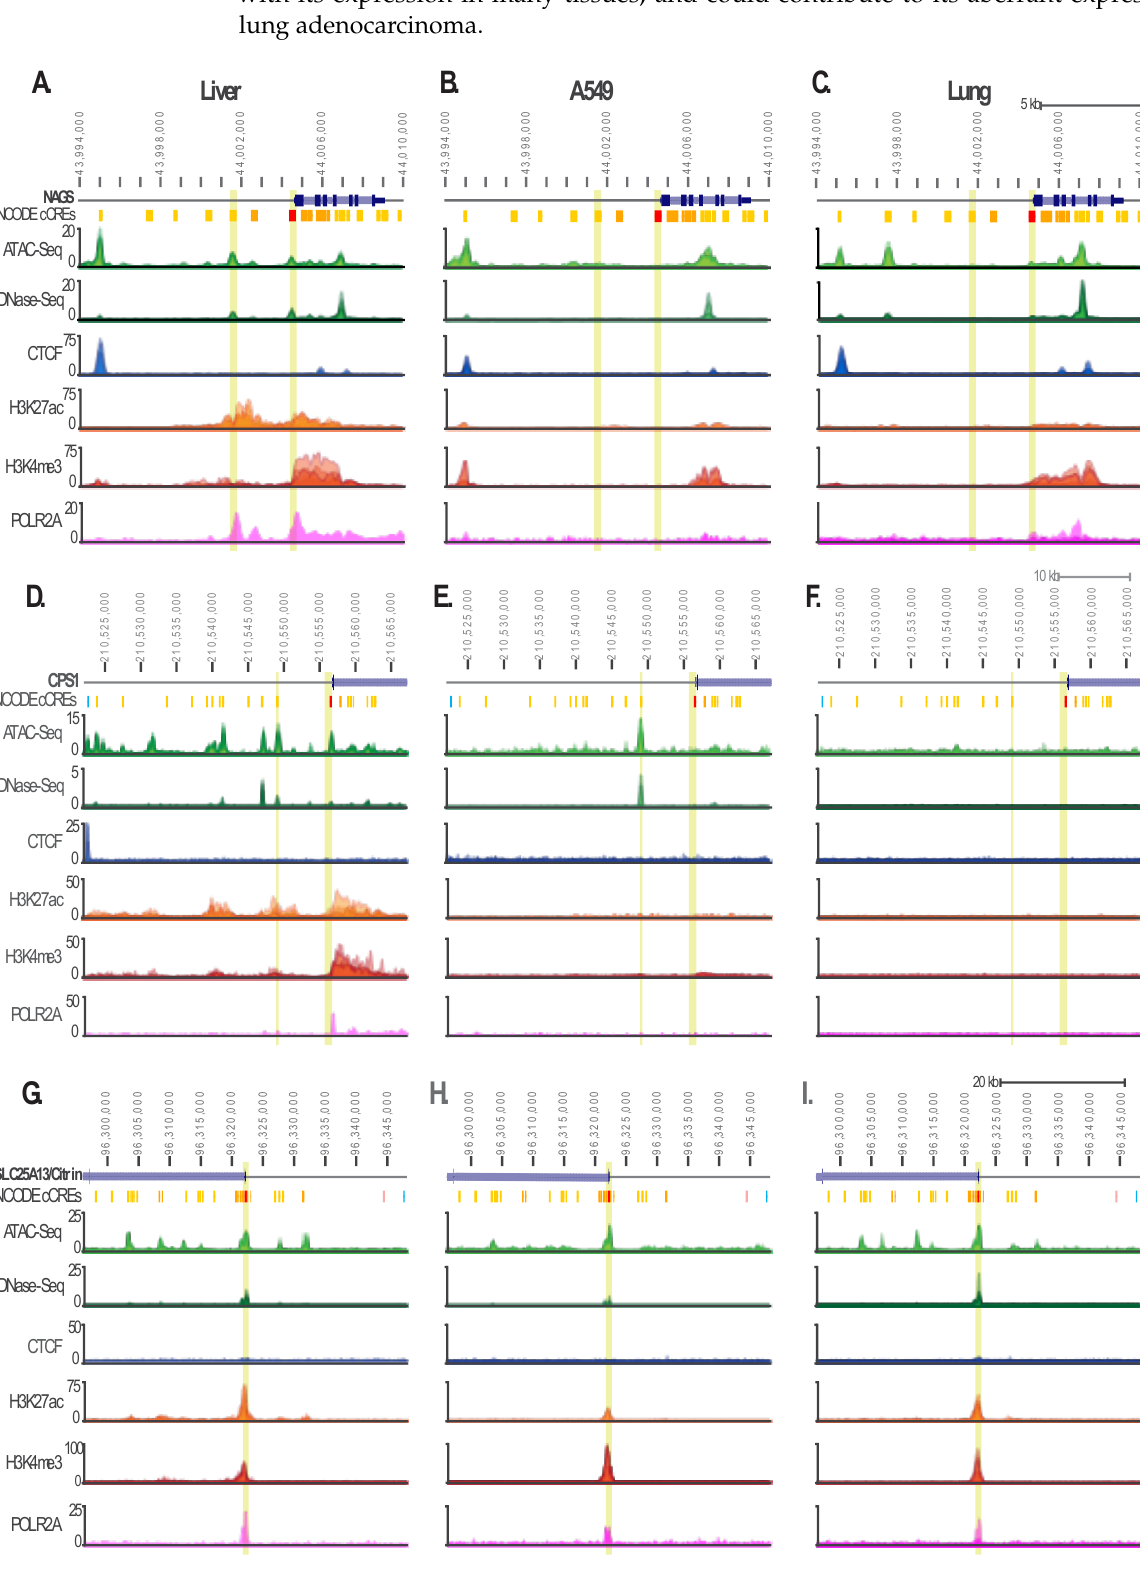
Figure 3. Epigenetic regulation of NAGS ( A – C ), CPS1 ( D – F ), and citrin ( G – I ) in the liver tissue ( A , D , G ), A549 cell line ( B , E , H ), and lung tissue ( C , F , I ). Chromatin accessibility (ATAC-Seq and DNase-Seq shown in light and dark green, respectively), CTCF binding (blue), acetylation of histone H3 lysine 27 (H3K27ac, shown in light orange), tri-methylation of histone H3 lysine 4 (H3K4me3, shown in dark orange), and binding of the 2A subunit of RNA polymerase II (POLR2A, shown in magenta) are shown for the following genomic regions: whole NAGS gene, approx. 10.5 kb of the upstream regulatory region and 1 kb downstream of the NAGS (chr17: 43,994,000 – 44,010,000); first